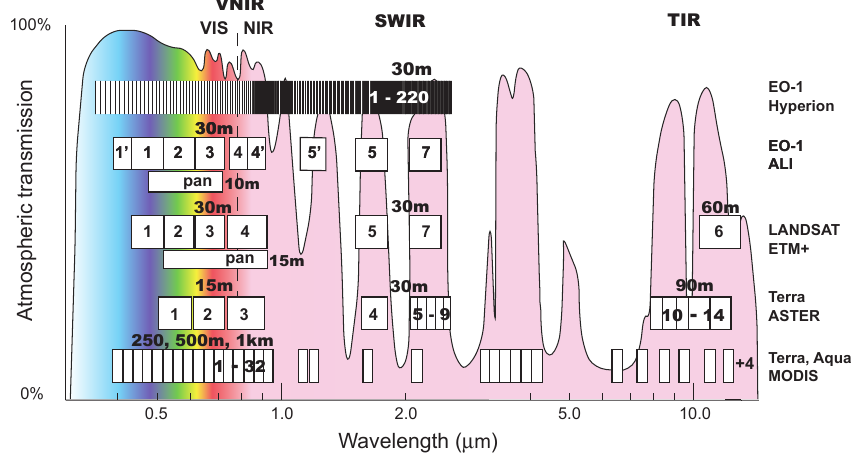
Fig. 1. Spectral and spatial resolution of Hyperion, ALI, Landsat ETM+, ASTER and MODIS sensors shown with respect to visible to thermal infrared atmospheric transmission (revised after (K¨a¨ab,